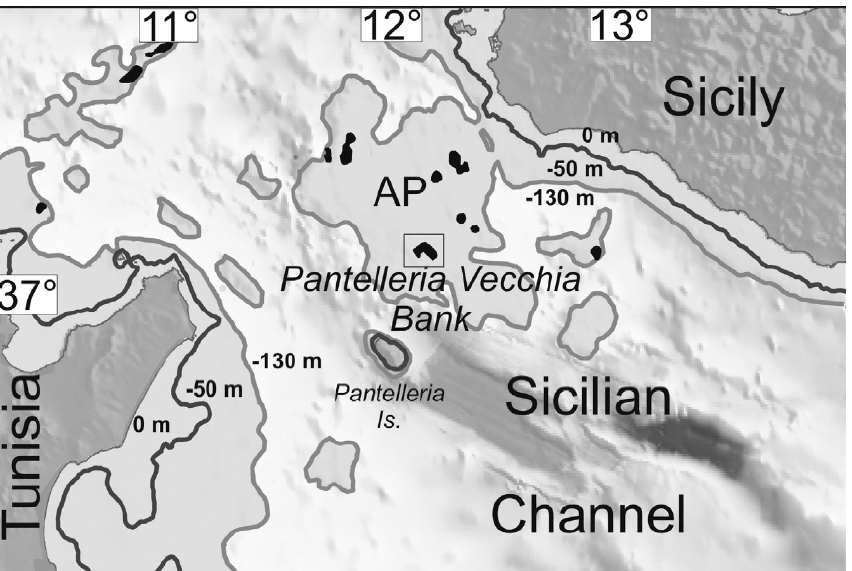
Figure 14. Adventure Plateau dominated by north-west trending, linked to Sicily during the LGM and a few km away from the island of Pantelleria (after Lodolo & Ben-Avraham [28]) (with permission by the authors).